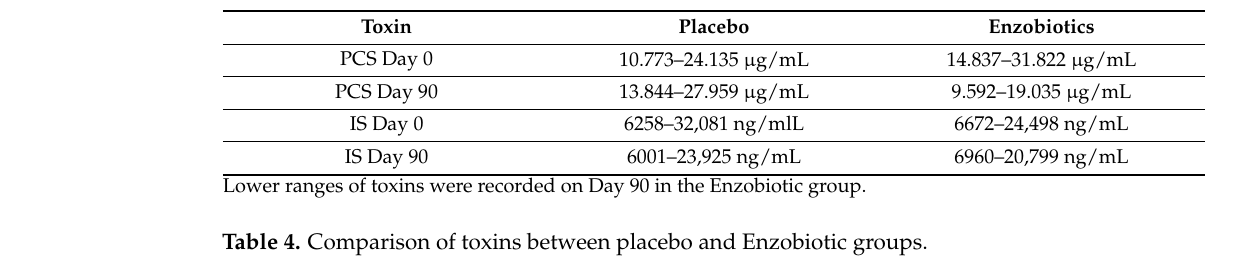
Table 3. Interquartile ranges of PCS and IS for Placebo and Enzobiotic groups.